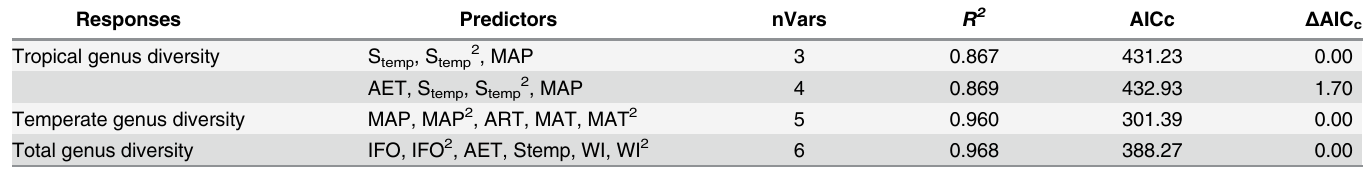
Table 2. Coefficients of determination ( R 2 ) and Akaike information criterions (AIC) of the best SAR models. There were 8, 16 and 32 possible SAR models for tropical, temperate and total genus diversity, respectively (see S5 Table). For each biogeographical group, the Δ AICc compares the best model ( Δ AICc = 0) with all of models generated, and any models with a Δ AICc of less than two in comparison with the best model were considered an equally good fit to the data.